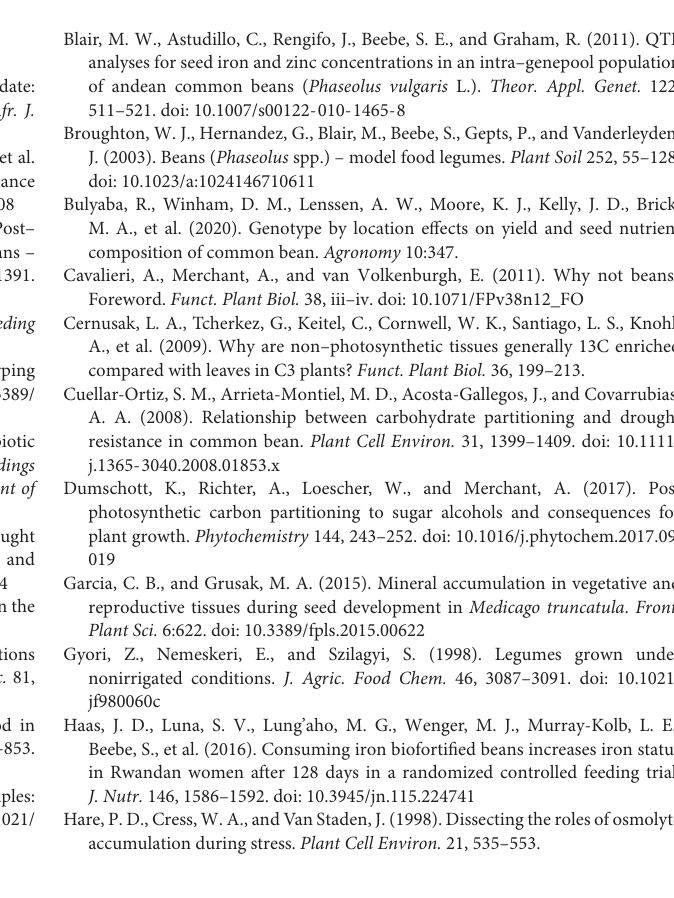
Supplementary Figure 1 | A/c i parameters V cmax ( µ mol/m 2 /s), J ( µ mol/m 2 /s) and TPU for common bean lines DOR390, SEF60, and NCB226 under treatments of high phosphorus well-watered (HPWW; blue) and low phosphorus well-watered (LPWW; light blue) at